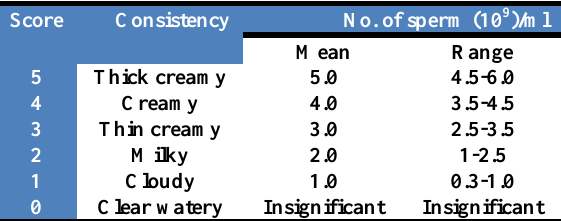
Table, 1: The color of semen according to Evan and Maxwell (1987).